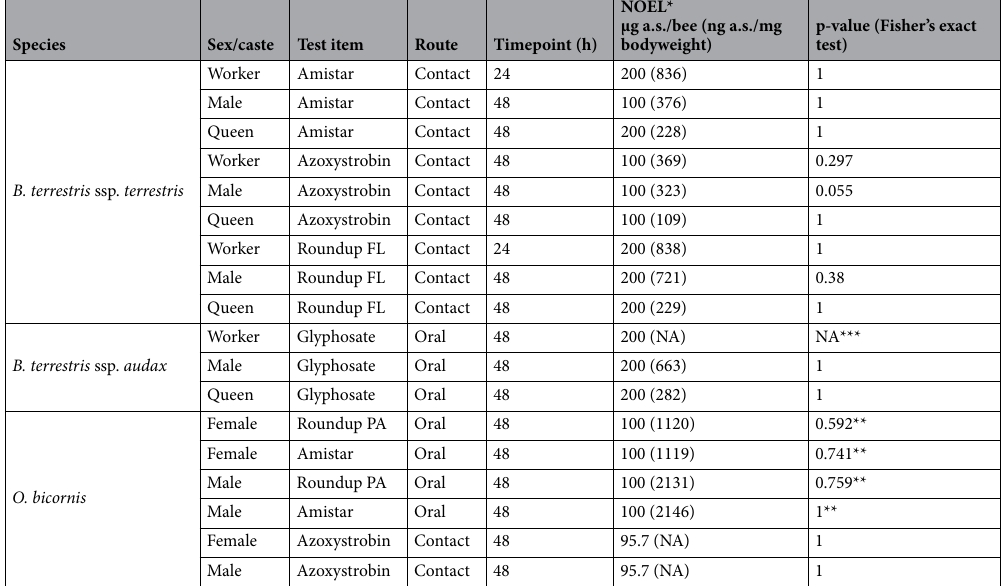
Table 3. The toxicity of Amistar and glyphosate (as active substance or formulation) across sexes and castes in the limit test designs. *No Observable Effect Level (highest dose causing no significant mortality). **Benjamini–Hochberg correction. ***Results published in Straw and Brown 50